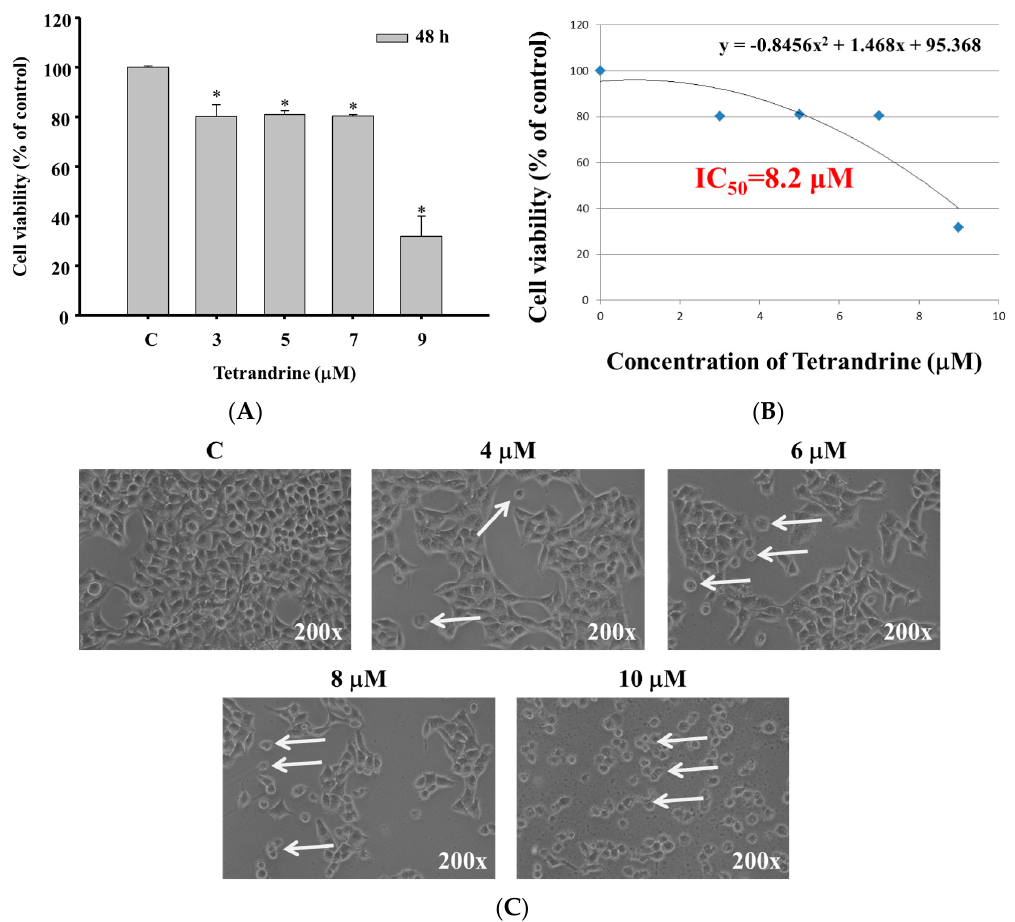
Figure 1. TET decreases the number of viable NPC-TW 076 cells and induced cell morphological changes in vitro. Cells were treated with TET at a concentration range of 0–10 μ M for 48 h and then the cells were collected for the percentage of viable cell measurements ( A ) by flow cytometry as described in Materials and Methods. IC 50 is examined to be 8.2 μ M ( B ). Cells were examined and photographed for cell morphological changes by contrast-phase microscopy at 200× ( C ) or * p < 0.05, significant difference between TET-treated groups and the control as analyzed by Student’s t test.